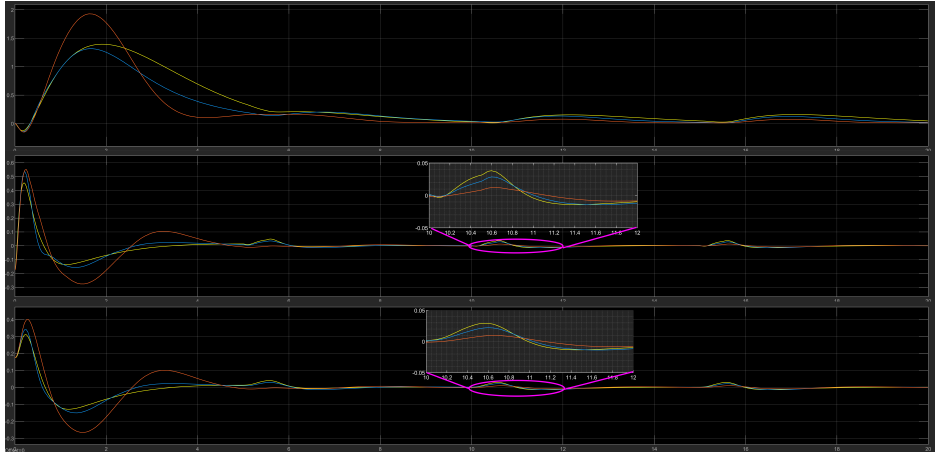
Figure 28. The DIP response under disturbance (first placement point) in the control signal with the LQR (yellow), FLC (blue) and modified FLC* (orange) controllers.